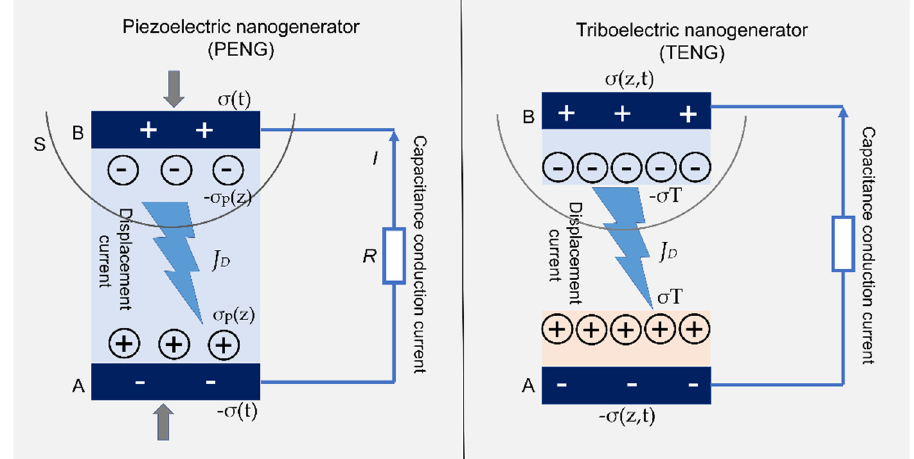
Figure 16. Schematic representation of piezoelectric nanogenerator (PENG) and triboelectric nano ‐ generator.